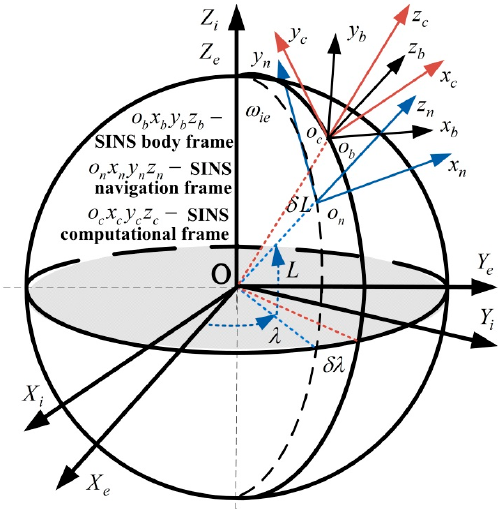
Figure 3. The coordinate systems and transformation relation for SINS.